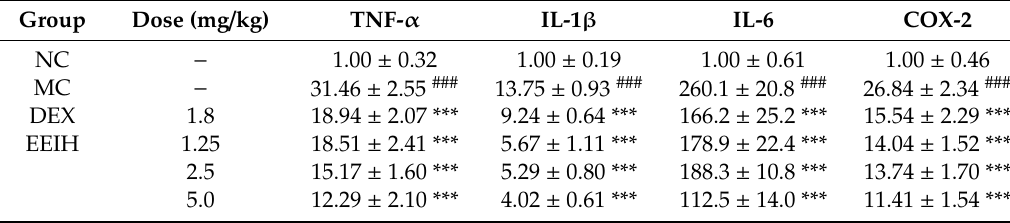
Table 5. E ff ects of EEIH on the mRNA expression levels of proinflammatory factors in renal tissue of LPS-treated